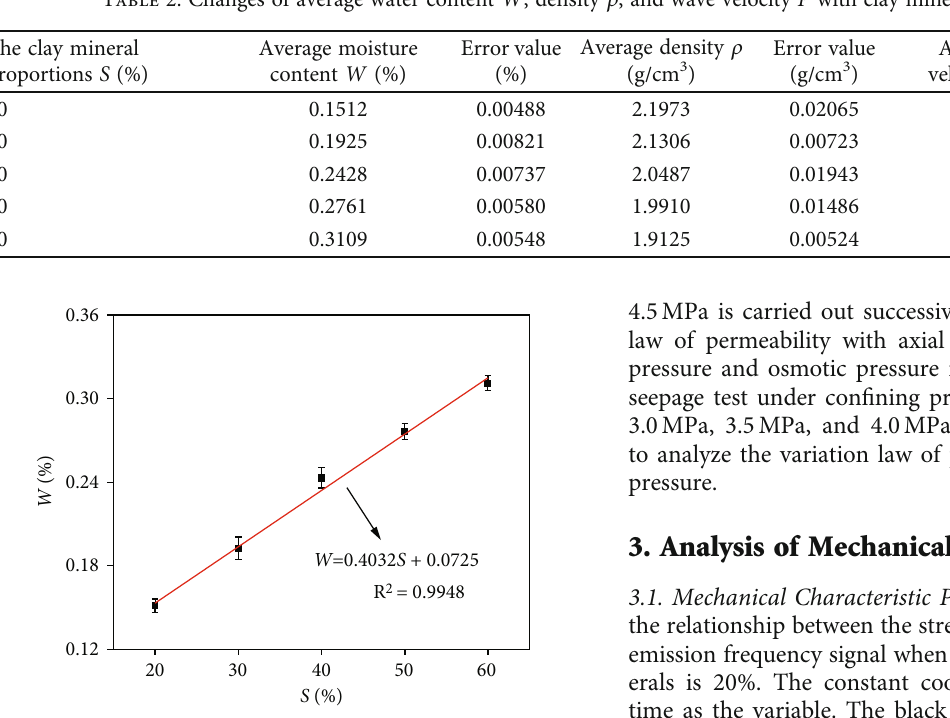
Figure 4: The water content W with S .